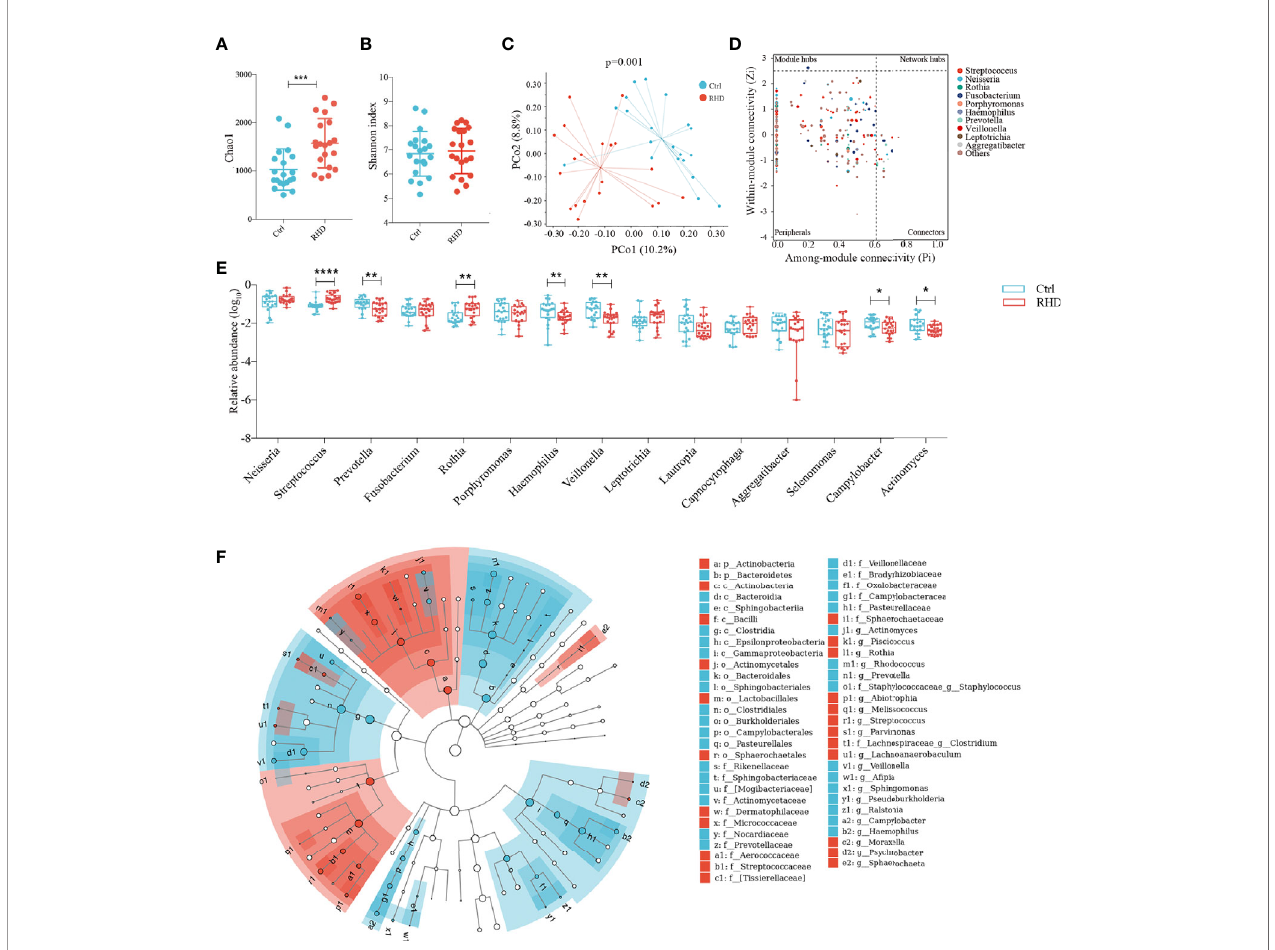
FIGURE 3 | Alterations of salivary microbiota in patients with rheumatic heart disease. Microbiota of saliva from patients with rheumatic heart disease (RHD) and control subjects (Ctrl) were analyzed using 16S rRNA gene sequencing. (A) Richness of salivary microbiota assessed by Chao1. (B) a -diversity of salivary microbiota assessed by Shannon index. (C) b -diversity analyzed by principal coordinate analysis (PCoA) based on Bray – Curtis distance of salivary microbiota at genus level. (D) Determination of module-based topological roles (peripherals, connectors, module hubs, or network hubs) of salivary microbiota in RHD patients using ZP-plot at genus level. The size of dots represents abundance of each genus. (E) Relative abundances of the fi fteen most abundant genera in salivary microbiota. (F) Taxonomic cladogram of salivary microbiota based on LEfSe. Red color indicates increase and blue indicates decrease of taxa in RHD compared to Ctrl. LDA = 3. Mann – Whitney test was used. n = 20: 20. *P < 0.05; **P < 0.01; ***P < 0.001; ****P <